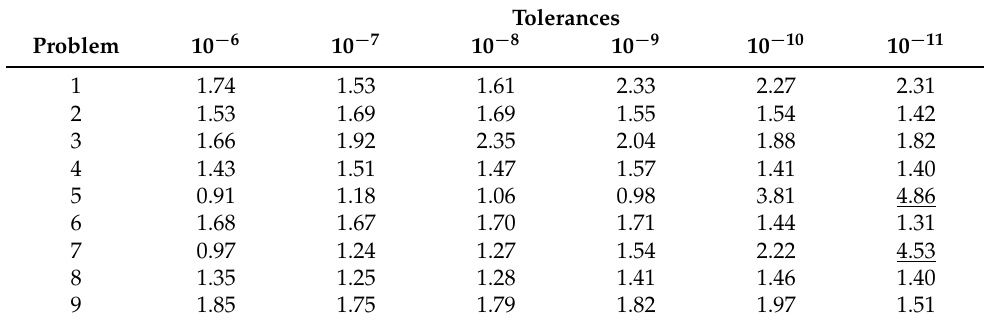
Table 3. Efficiency measures ratios of DLMP6(5) vs NEW6(5).